Question: Looking at the figure, what chart type is it?
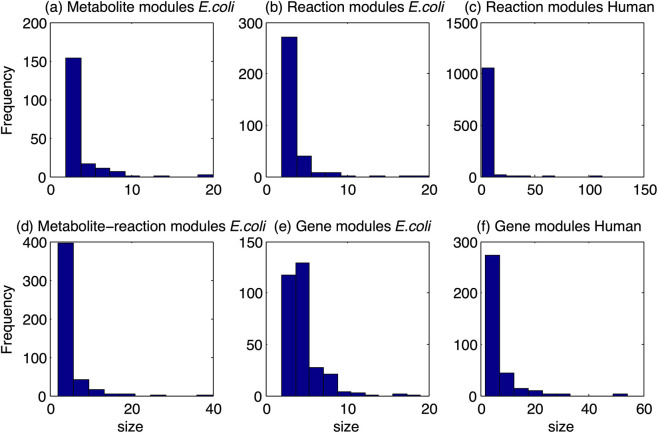
Answer: histogram